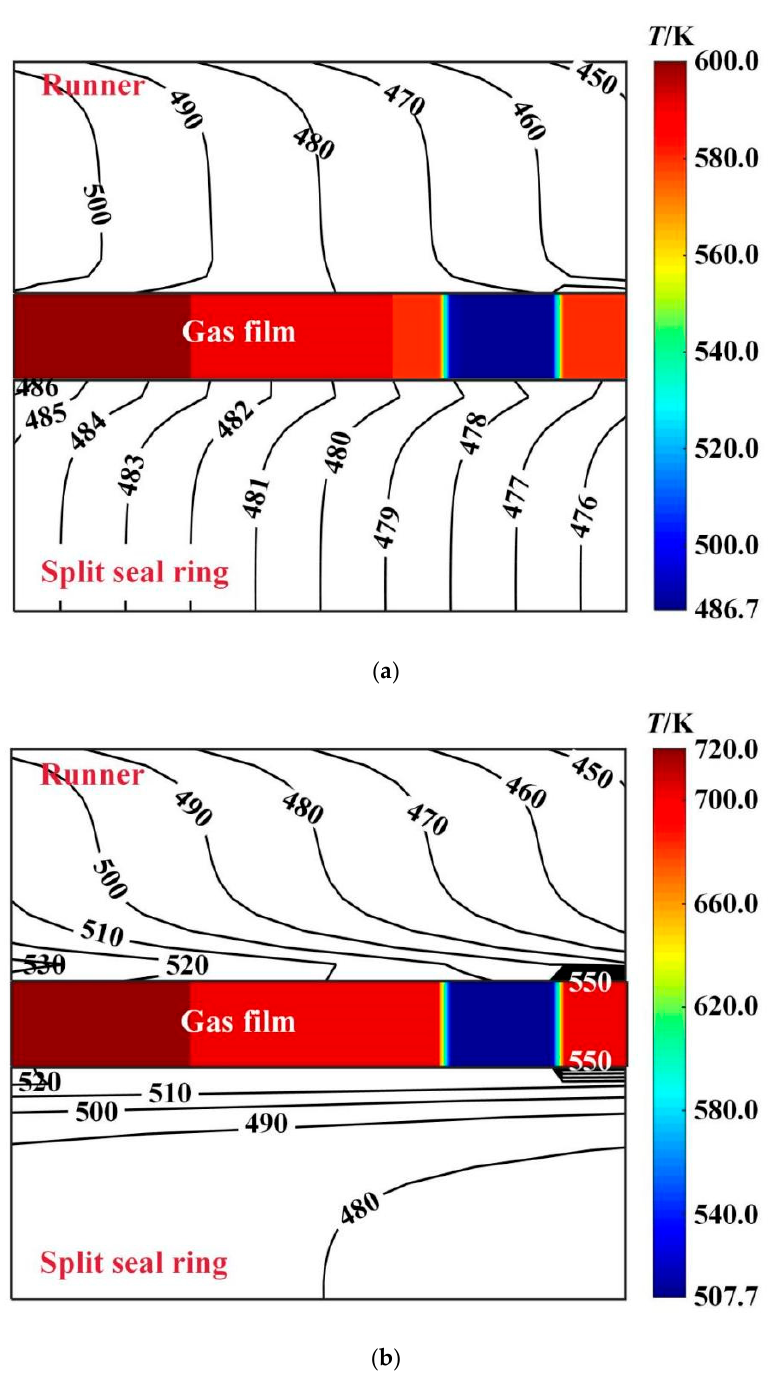
Figure 9. Influence of rotation speed on the maximum temperature of gas film. ( p i = 0.2 MPa, ω = 4.0 × 10 4 r/min, T in = 580 K, T out = 380 K). ( a ) β = 6×10 − 6 rad; ( b ) β = 0.